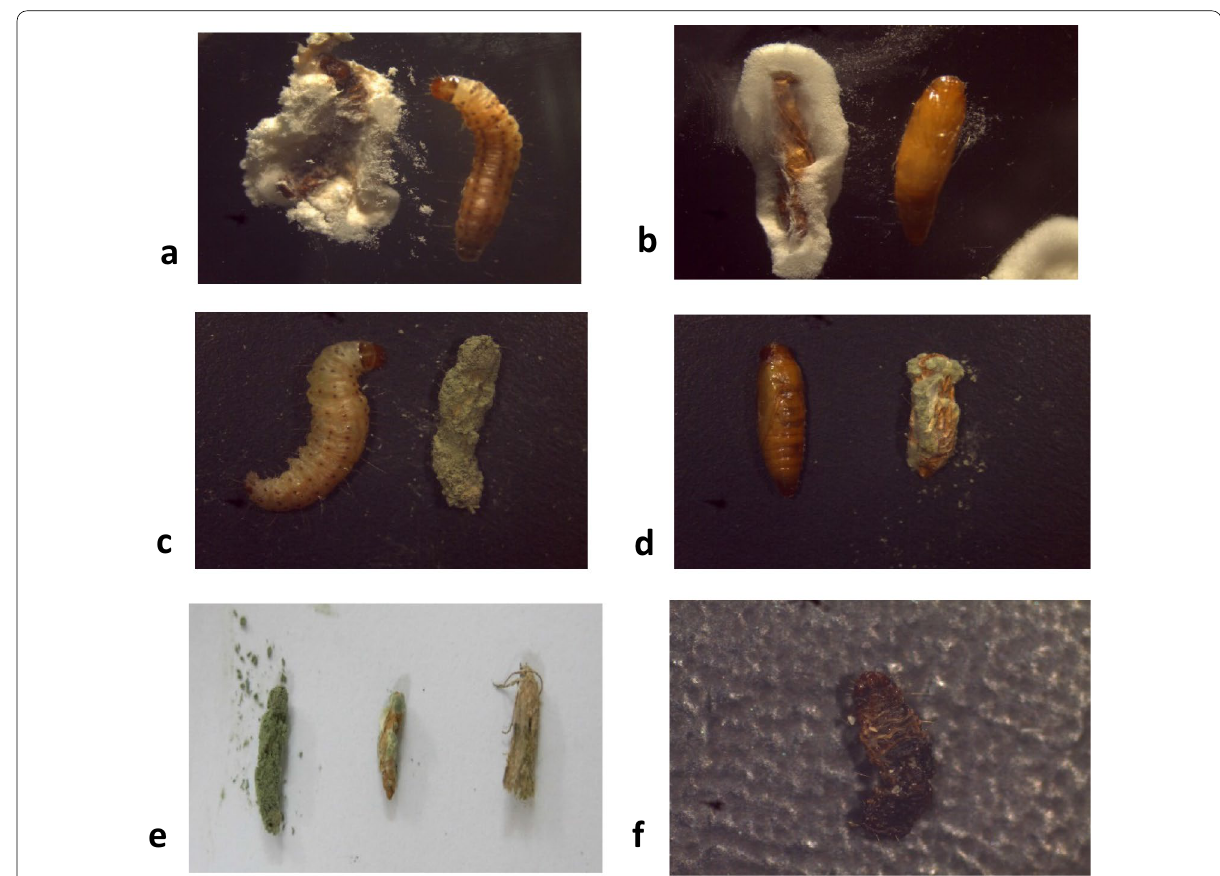
Fig. 1 a , b Cadaver of Ephestia cautella larva & pupa covered with white muscardine ( Beauveria bassian a). c , d Cadaver of E. cautella larva,pupa covered with green muscardine ( Metarhizum anisopliae ). e Cadaver of E. cautella larva, pupa and adult covered with green muscardine ( M.